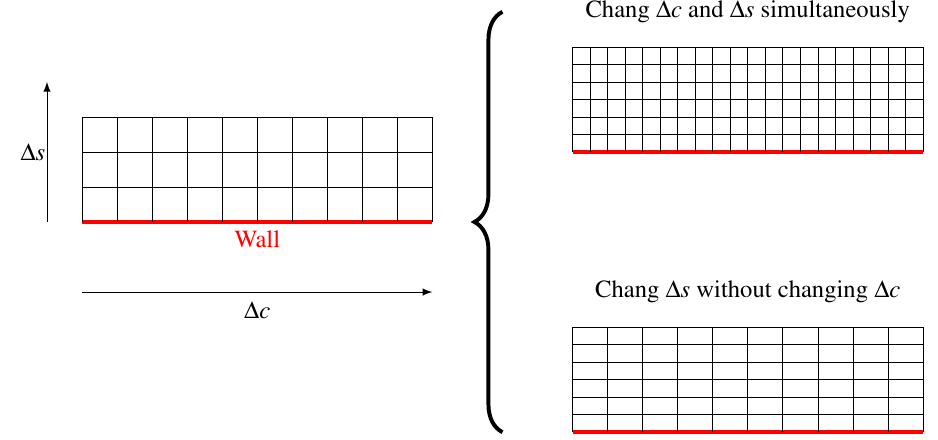
Figure 9. Impacts of height of first mesh ∆ s on aspects